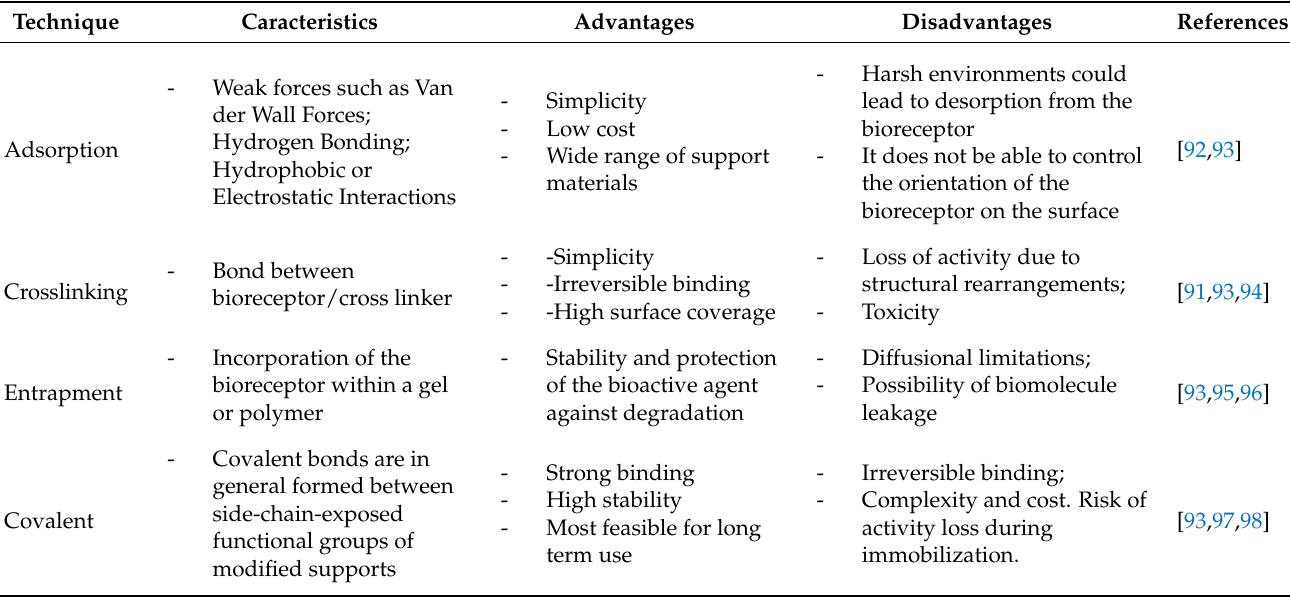
Table 4. Immobilization